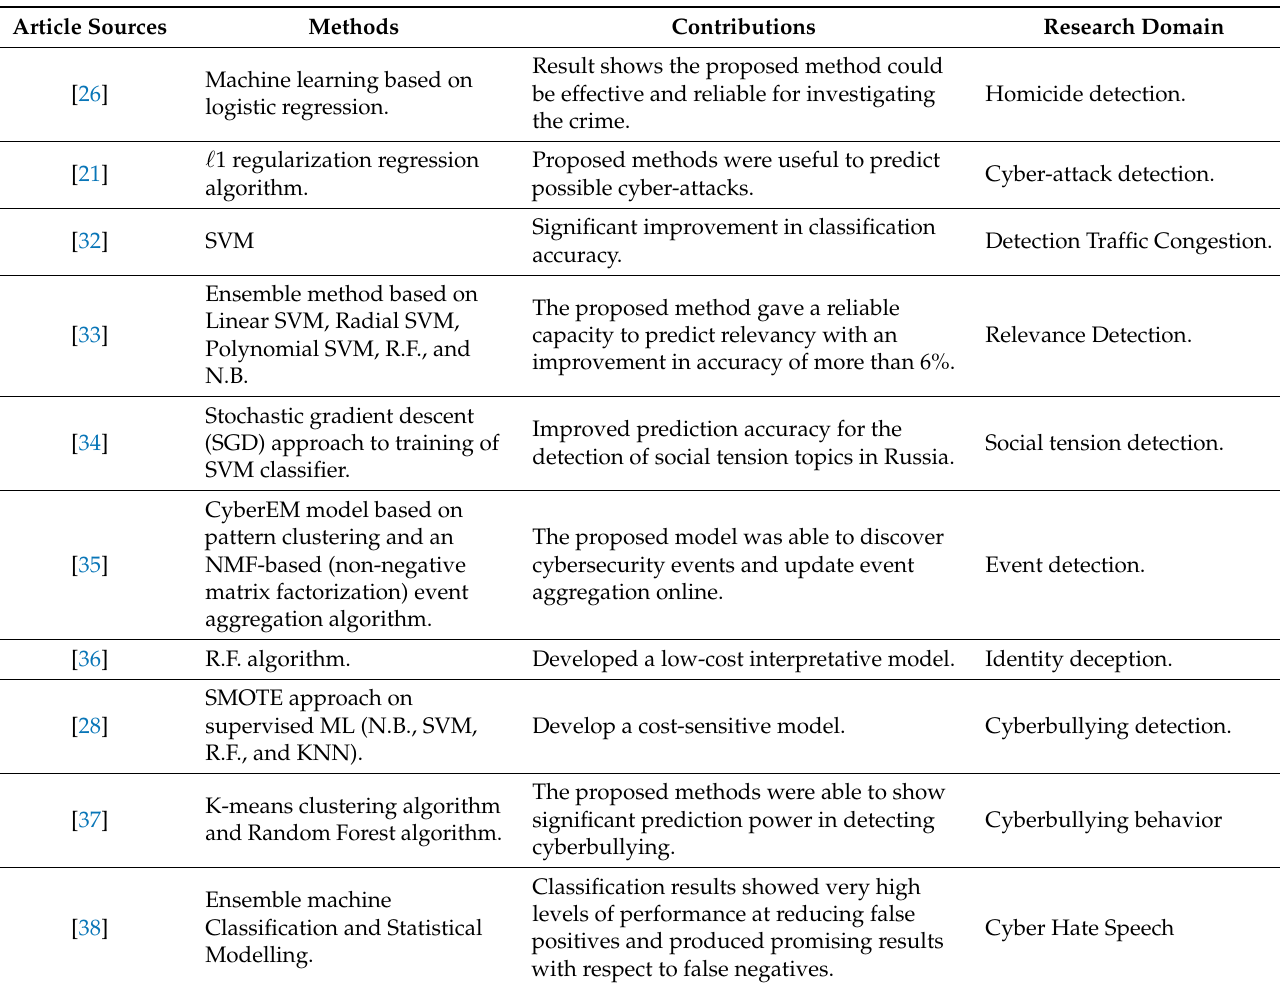
Table 1. Summary of related work on cybercrime analysis using Twitter